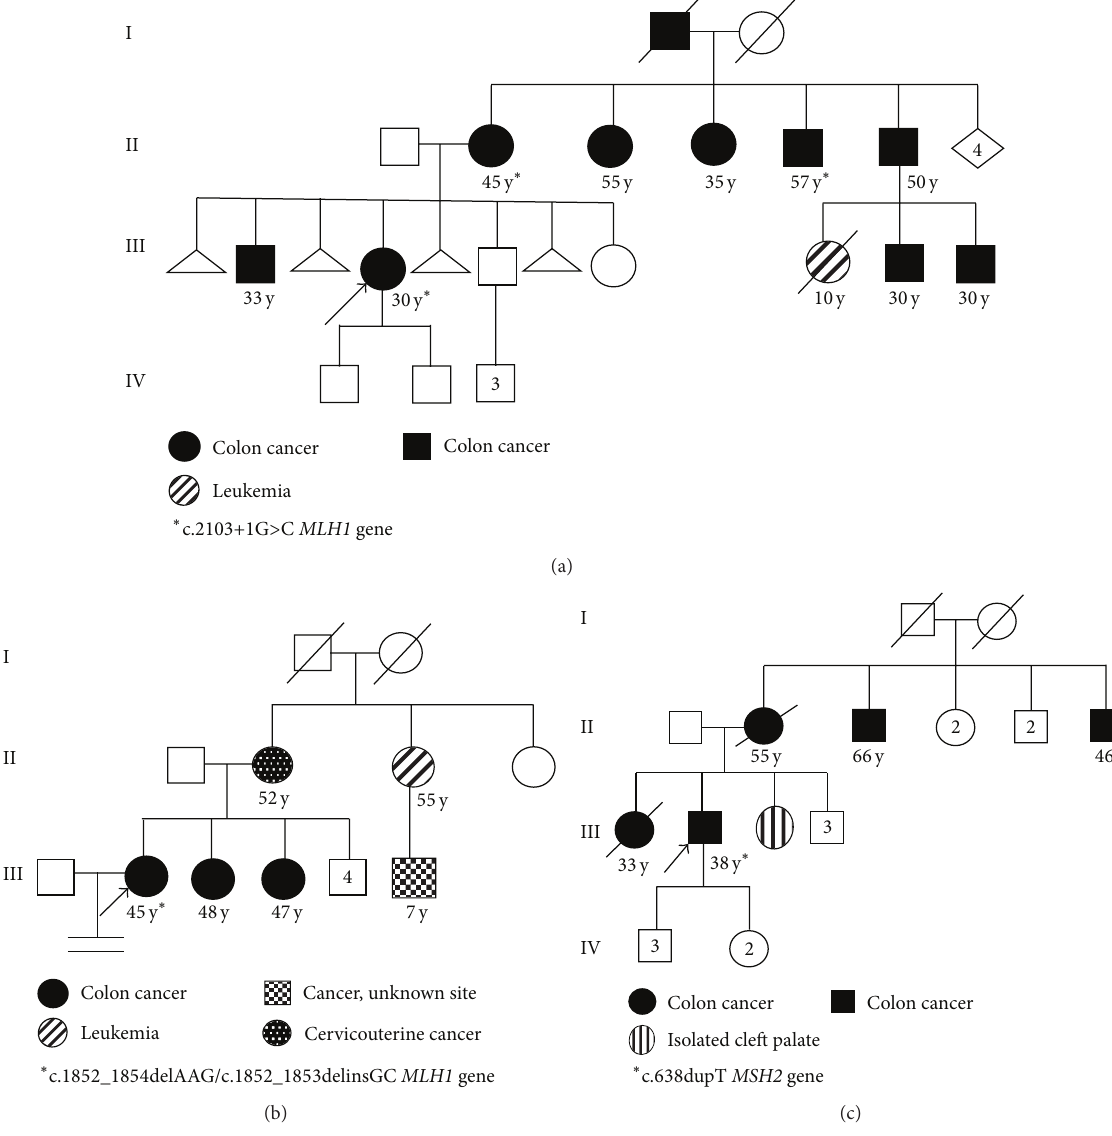
Figure 1: Genealogies from three LS families. (a) Family LS-23, (b) Family LS-41, and (c) Family